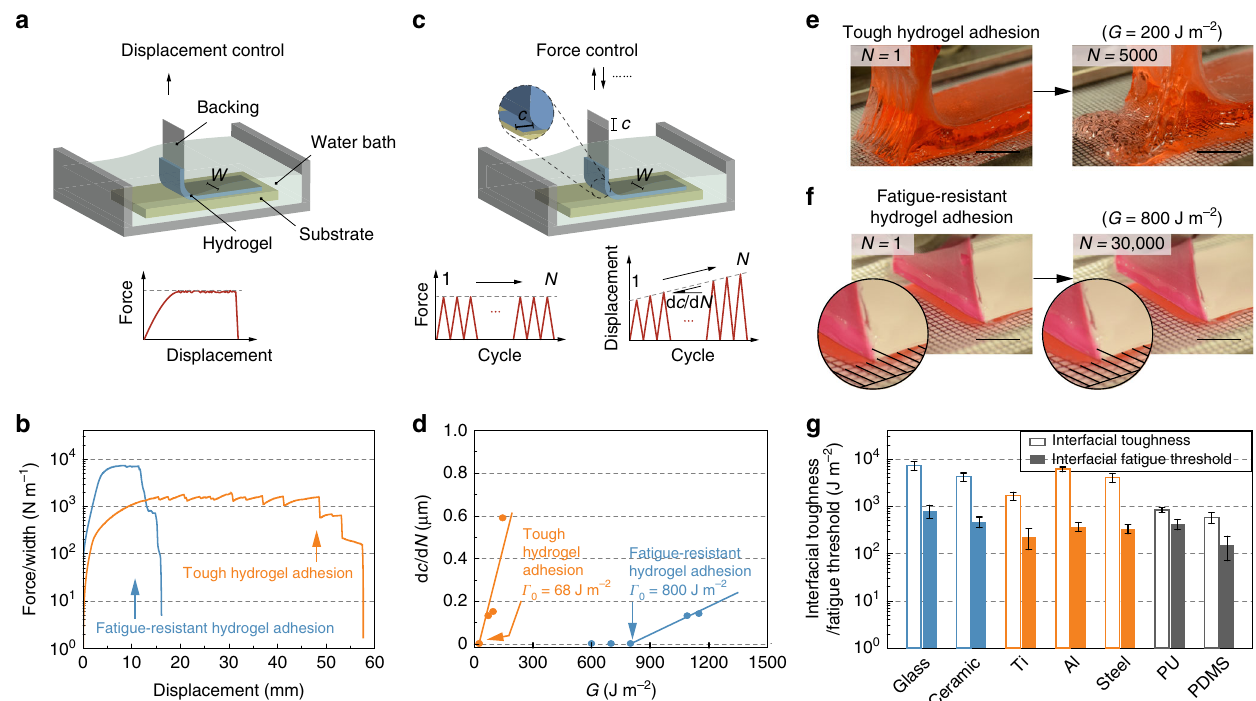
Fig. 2 Mechanical characterization of fatigue-resistant hydrogel adhesion. a Schematic illustration of measuring nominal peeling force F versus displacement curve during a single cycle of loading within a water bath. b Representative curves of the peeling force per width of the hydrogel ( F / W ) versus displacement for the tough hydrogel adhesion (i.e., PAAm-alginate) and fatigue-resistant hydrogel adhesion (i.e., PVA) on a glass substrate. c Schematic illustration of measuring the interfacial crack extension c versus cycle number N during a cyclic peeling test at a peeling force of F a . d Plot of crack extension rate (d c /d N ) versus applied energy release rate G = F a / W for the tough hydrogel adhesion and fatigue-resistant hydrogel adhesion on a glass substrate. The linear extrapolation to the G -axis gives the fatigue threshold Γ 0 . e Images of interfacial crack propagation during a cyclic peeling test for tough hydrogel adhesion with a thickness around 3 mm (swollen state) at an energy release rate of 200 J m − 2 , showing substantial interfacial crack propagation within 5000 cycles. f Images of interfacial crack propagation during a cyclic peeling test for fatigue-resistant hydrogel adhesion with a thickness around 100 μ m (swollen state) at an energy release rate of 800 J m − 2 , showing no interfacial crack propagation within 30,000 cycles. g Summary of measured interfacial toughness and interfacial fatigue threshold for fatigue-resistant hydrogel adhesion on various substrates, including glass, ceramic, titanium (Ti), aluminum (Al), stainless steel, PU, and PDMS. Error bars = standard deviation ( n = 3). Scale bars: 10 mm in ( e , f